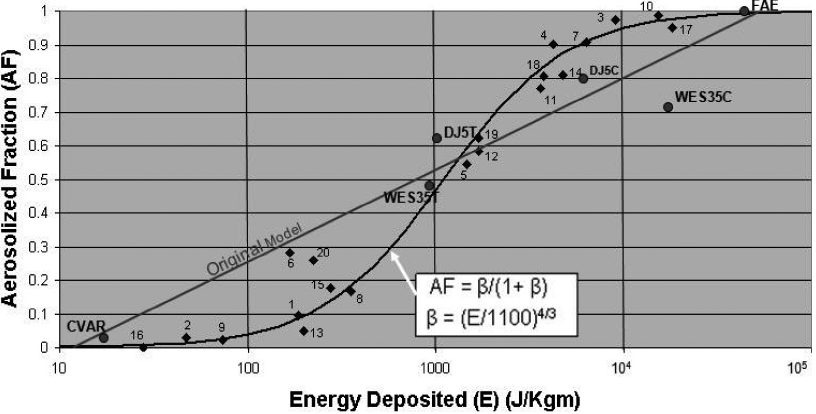
Fig. 10. Aerosolized fraction versus energy